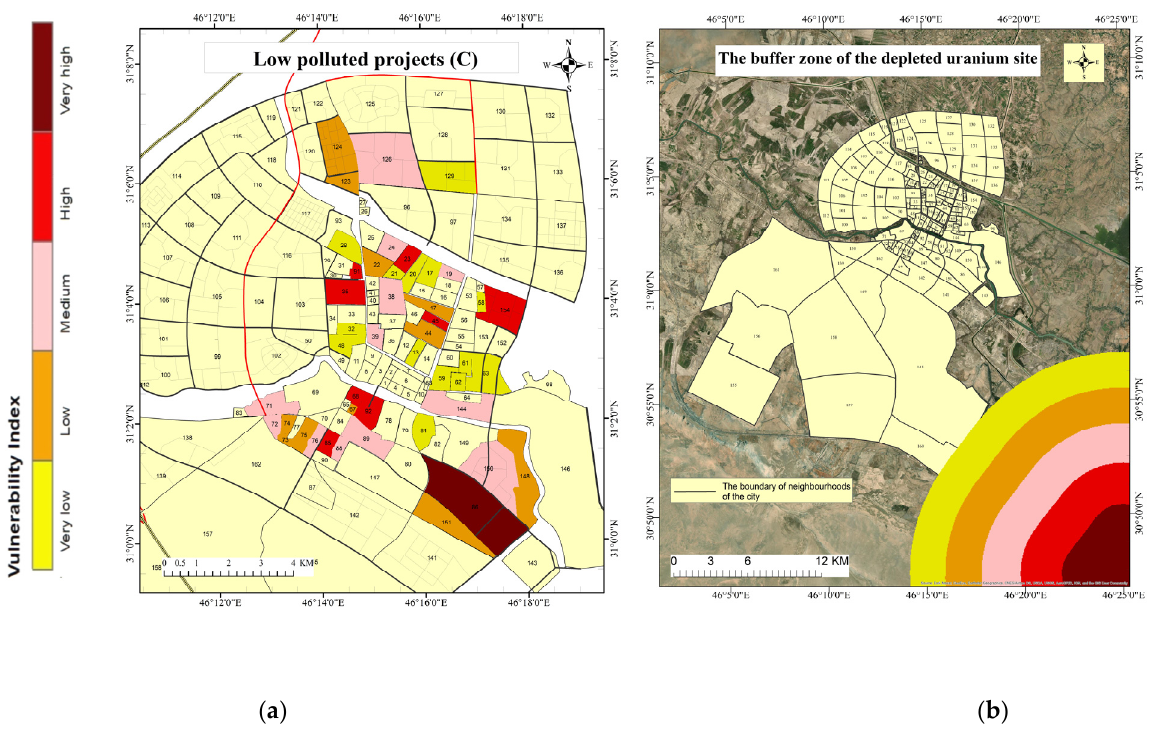
Figure 19. Sub-criteria of the environmental domain: ( a ) map of the low-polluting projects (C3) and ( b ) buffer zones of DU landfill (C4).